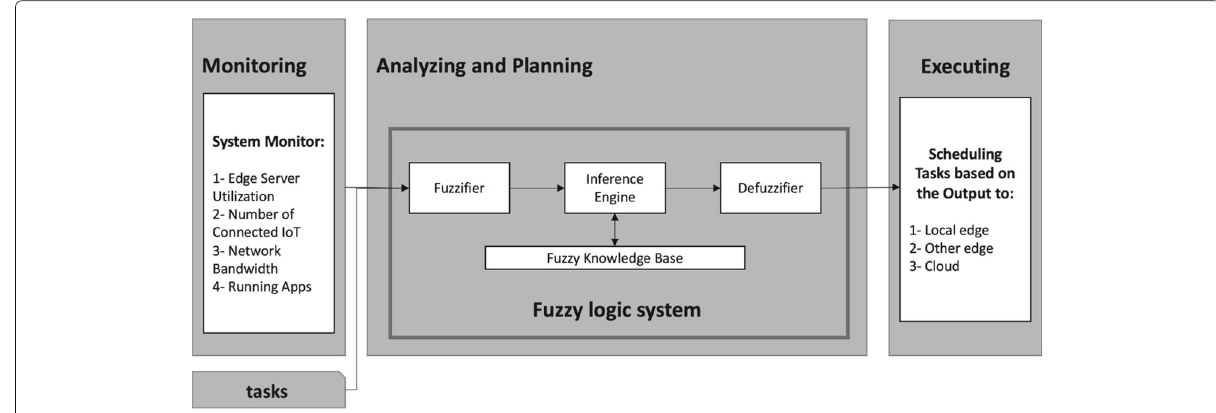
Fig. 2 The proposed approach of scheduling offloading